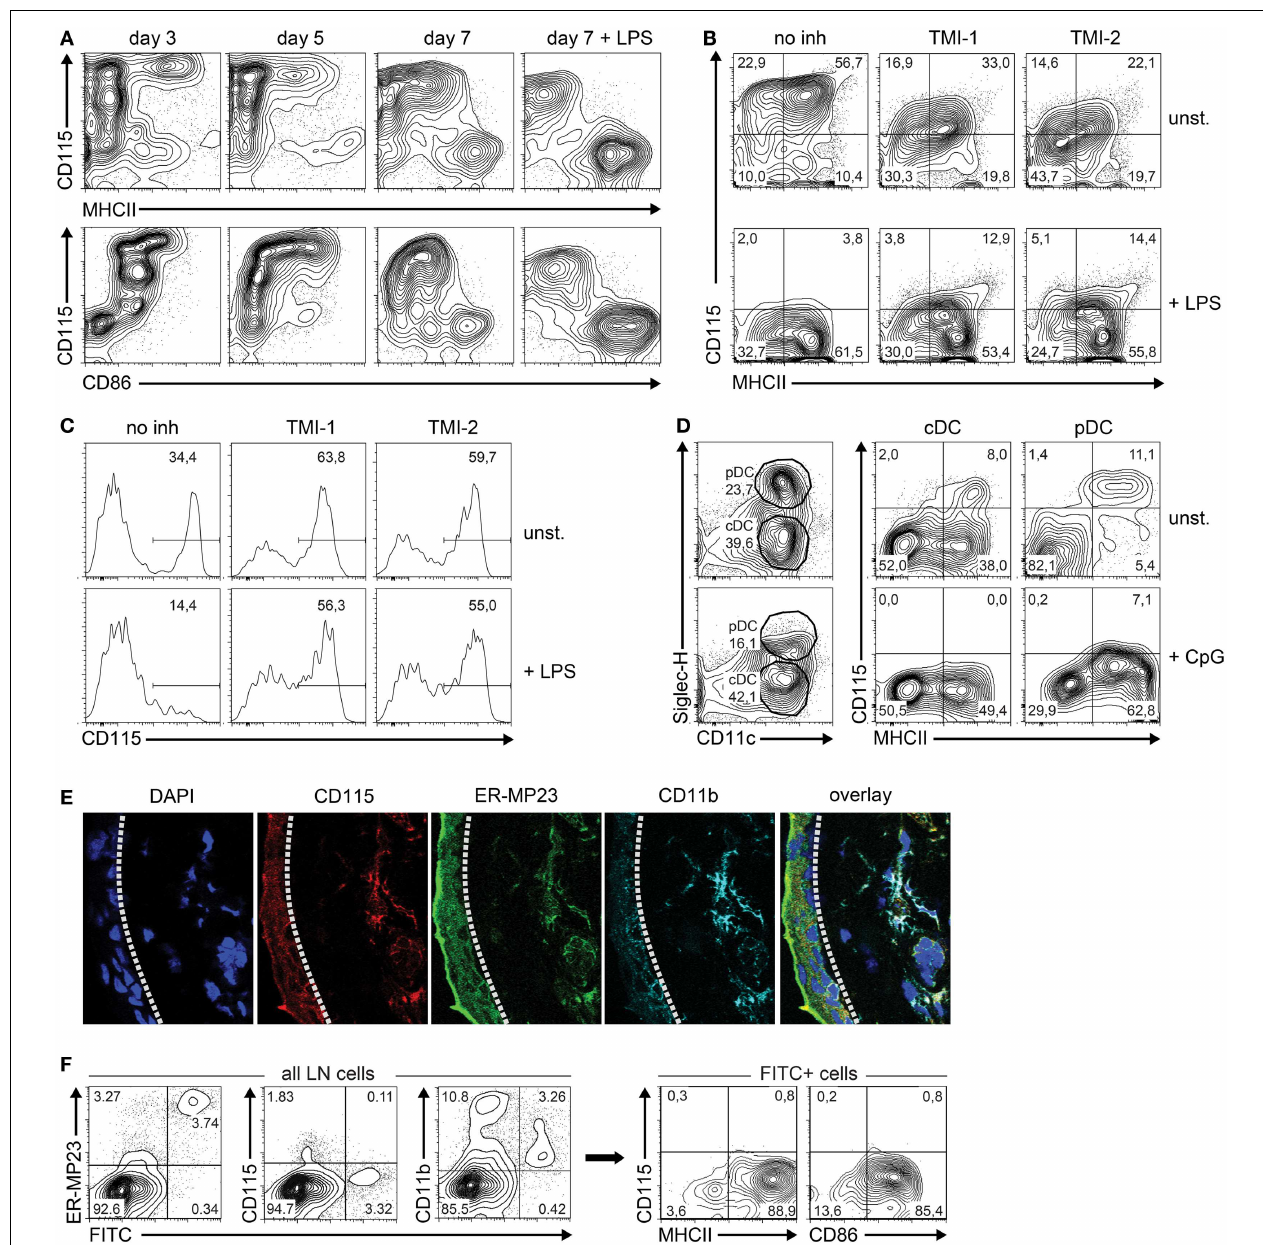
shown). Next, differential SiglecH and CD11c expression was used to distinguish between pDC (CD11c + SiglecH + ) and cDC (CD11c + SiglecH – ). CD115 expression was plotted against the DC maturation marker MHC class II for both cDC and pDC. Results are shown of a representative experiment of three with similar outcome. (E) Macrophages and M-CSFR-dependent immature DC in sections of mouse ear skin dermis were identified by CD115 (red), mMGL/CD301 (green), CD11b (cyan), and DAPI (blue), and detected by confocal microscopy.The dashed line indicates the border of the epidermis (left) and dermis (right). (F) Analysis of skin-derived FITC + cells migrated to skin-draining LN. Mice were skin-painted on shaved back with a 1% FITC solution. After 24h, skin-draining LN were isolated, processed into single-cell suspensions by mechanical means only and analyzed using flow cytometry. FITC + cells emigrated from the skin were found to represent primarily CD11c + MHCII hi CD86 hi cells lacking CD115 expression. Results of (E,F) are shown of a representative experiment of three with similar